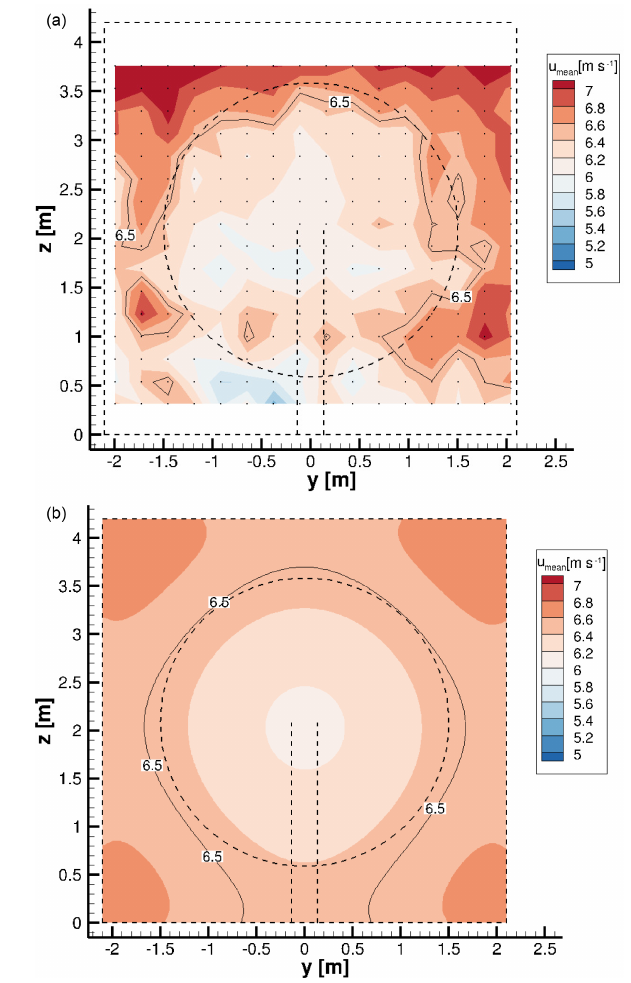
Figure 8. : Hot-wire measurements (a) and simulated velocity plane (b) of the x velocity 0 . 43 d upstream of the rotor plane. The dashed lines illustrate the wind tunnel and the turbine. Isolines show the undisturbed inflow velocity of 6 . 5ms − 1 . The dots in (a) show the discrete measuring points.